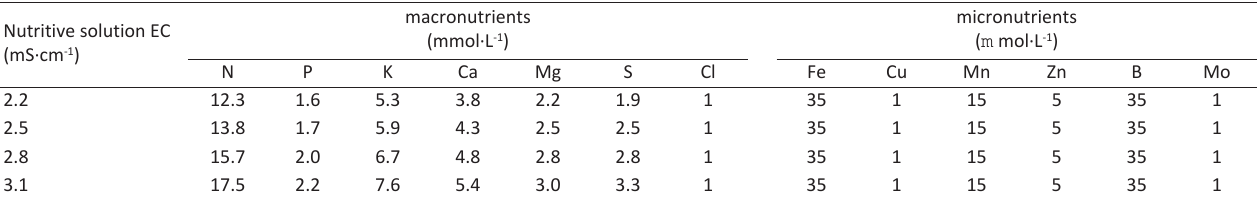
For all treatments pH was adjusted to 6.0 and NH 4 /NO 3 ratio was 1/9.